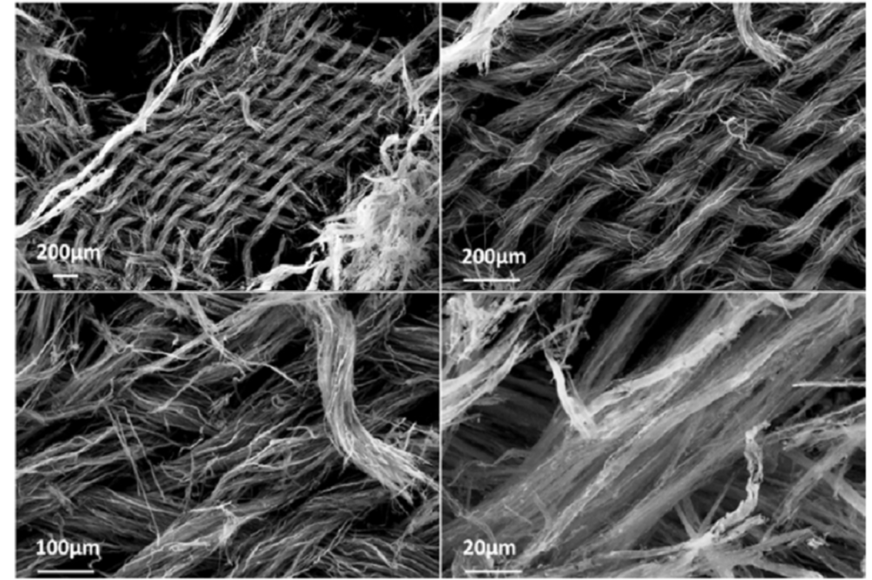
Figure 6. SEM of denatured whey-protein-treated Cotton [41].